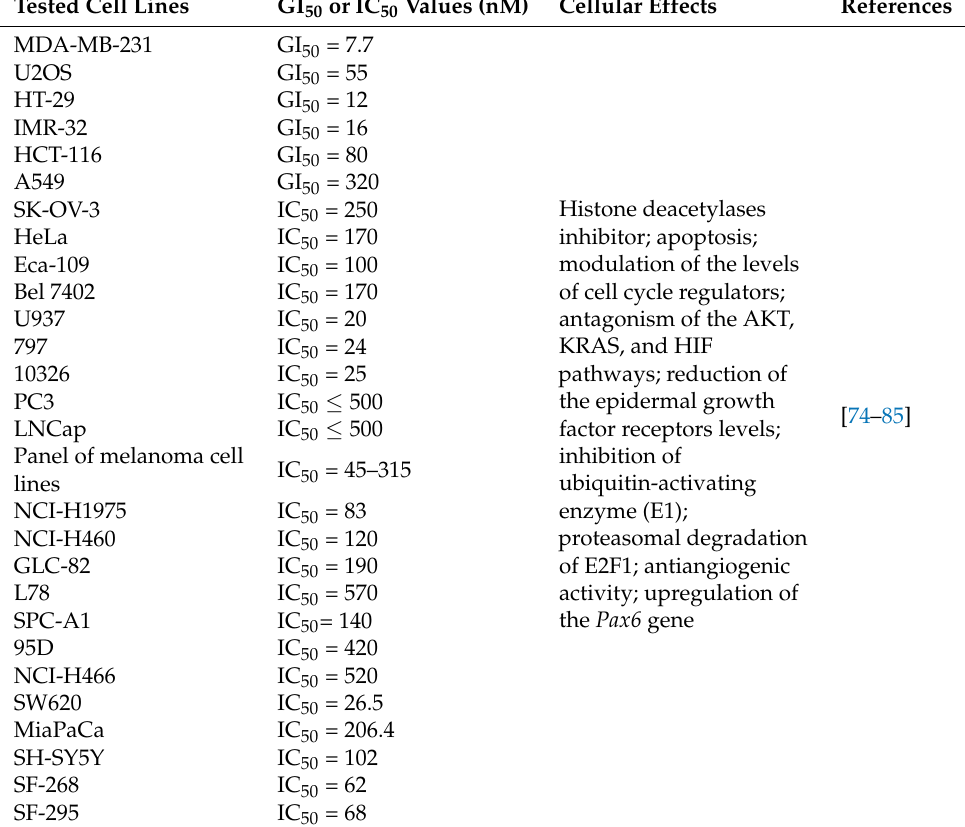
Table 7. Largazole biological activity on cancer cell lines. Tested Cell